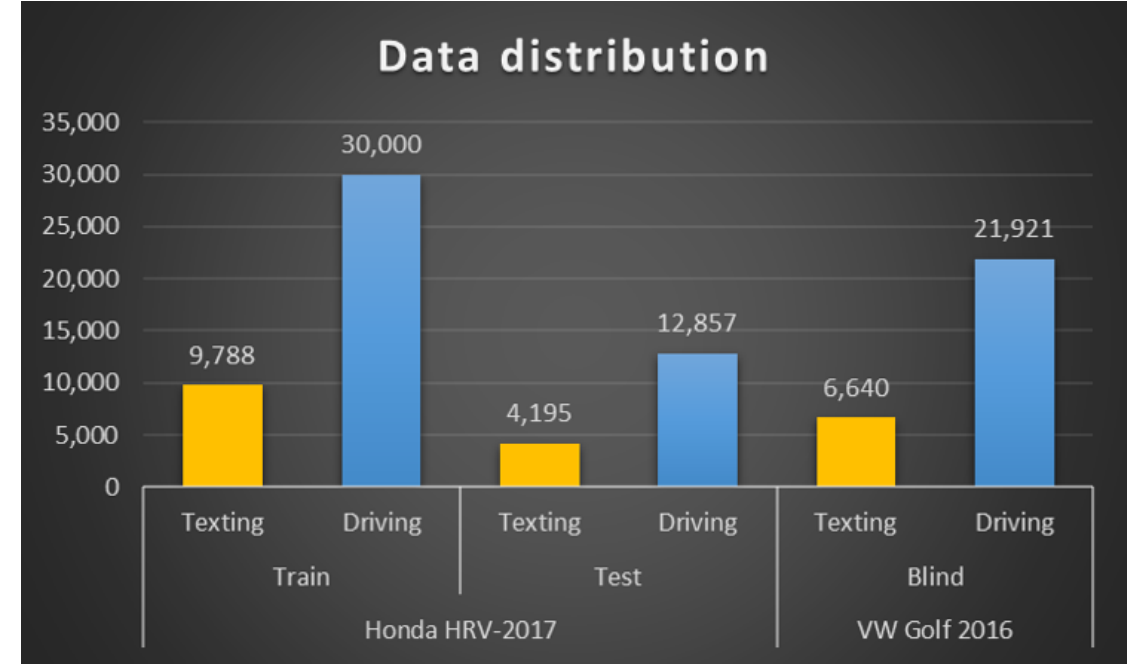
Figure 4. Experiment image data